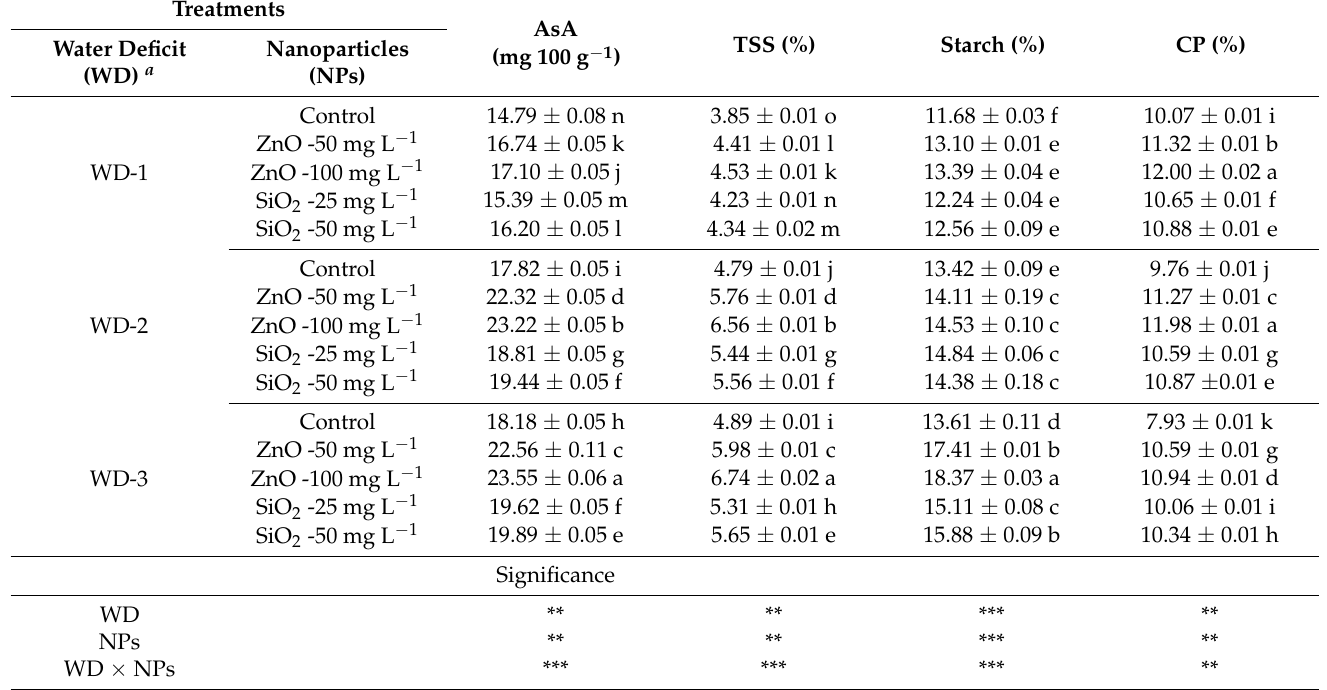
Table 4. Influence of foliar nanoparticles (NPs) on quality attributes: ascorbic acid (AsA), total soluble solids (TSS), starch, and crude protein (CP) of potato tubers grown under water deficit conditions (irrigation